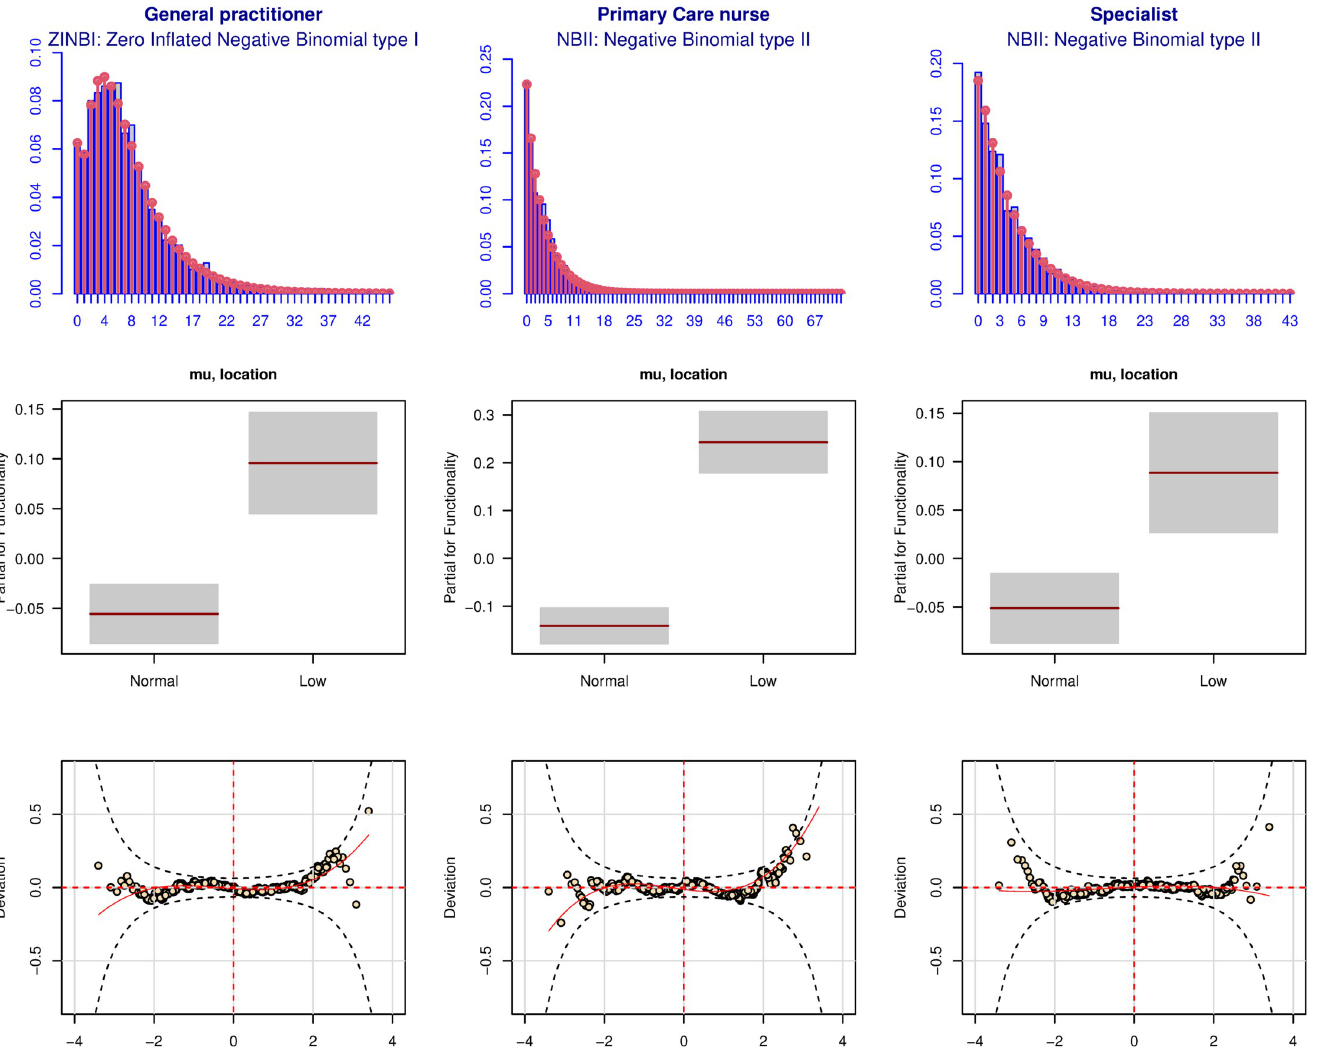
Fig 1. Goodness of fit of the models related to use of primary and secondary care services. The first row of figures shows the histograms of the observed data (in gray) where the selected distribution is adjusted (in red) for each service; second row, the partial effect of functionality in each model; and the third row, the worm- plots of the models (the more horizontal the red line, the better the model fits the